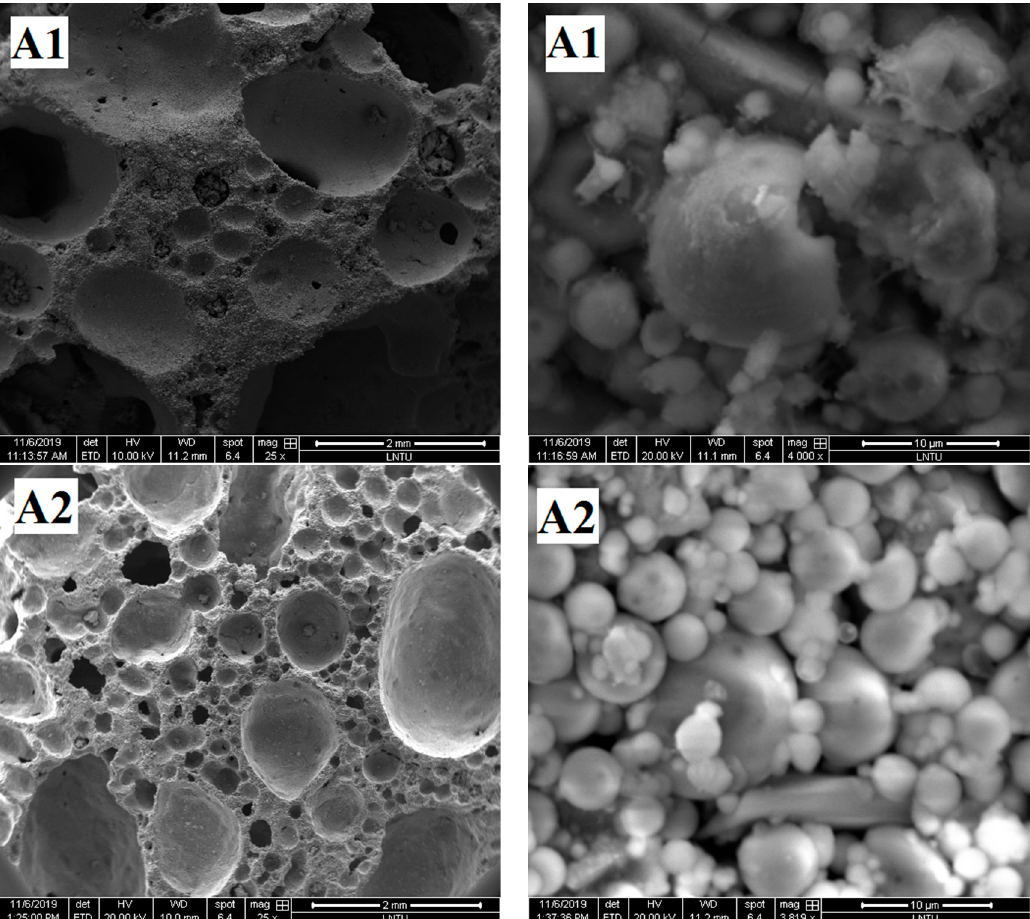
Figure 5. XRD diffraction pattern of foamed geopolymer based on fly ash. ( a ) XRD patterns of samples A1, A2, A3, ( b ) XRD patterns of samples B1, B2, B3, ( c ) XRD patterns of samples C1, C2, C3, ( d ) XRD patterns of samples D1, D2, D3, and ( e ) XRD patterns of samples E1, E2,